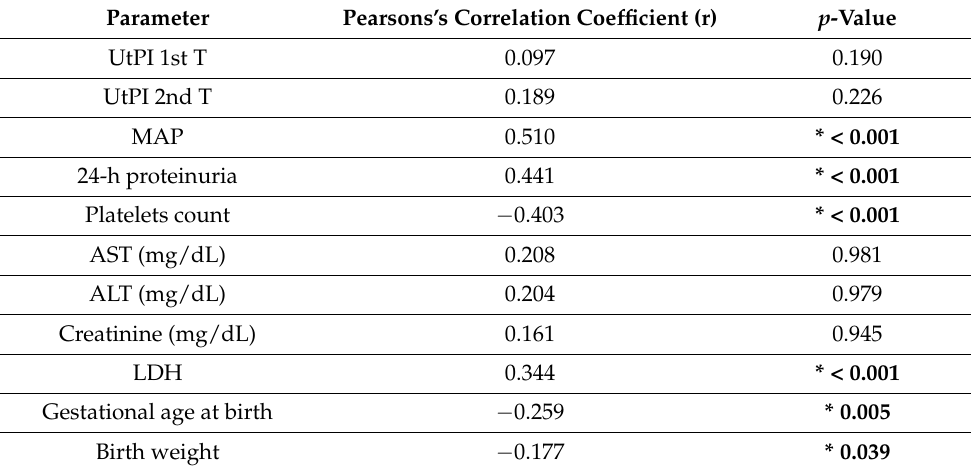
Table 4. CA-125 levels’ correlations with clinical–biological